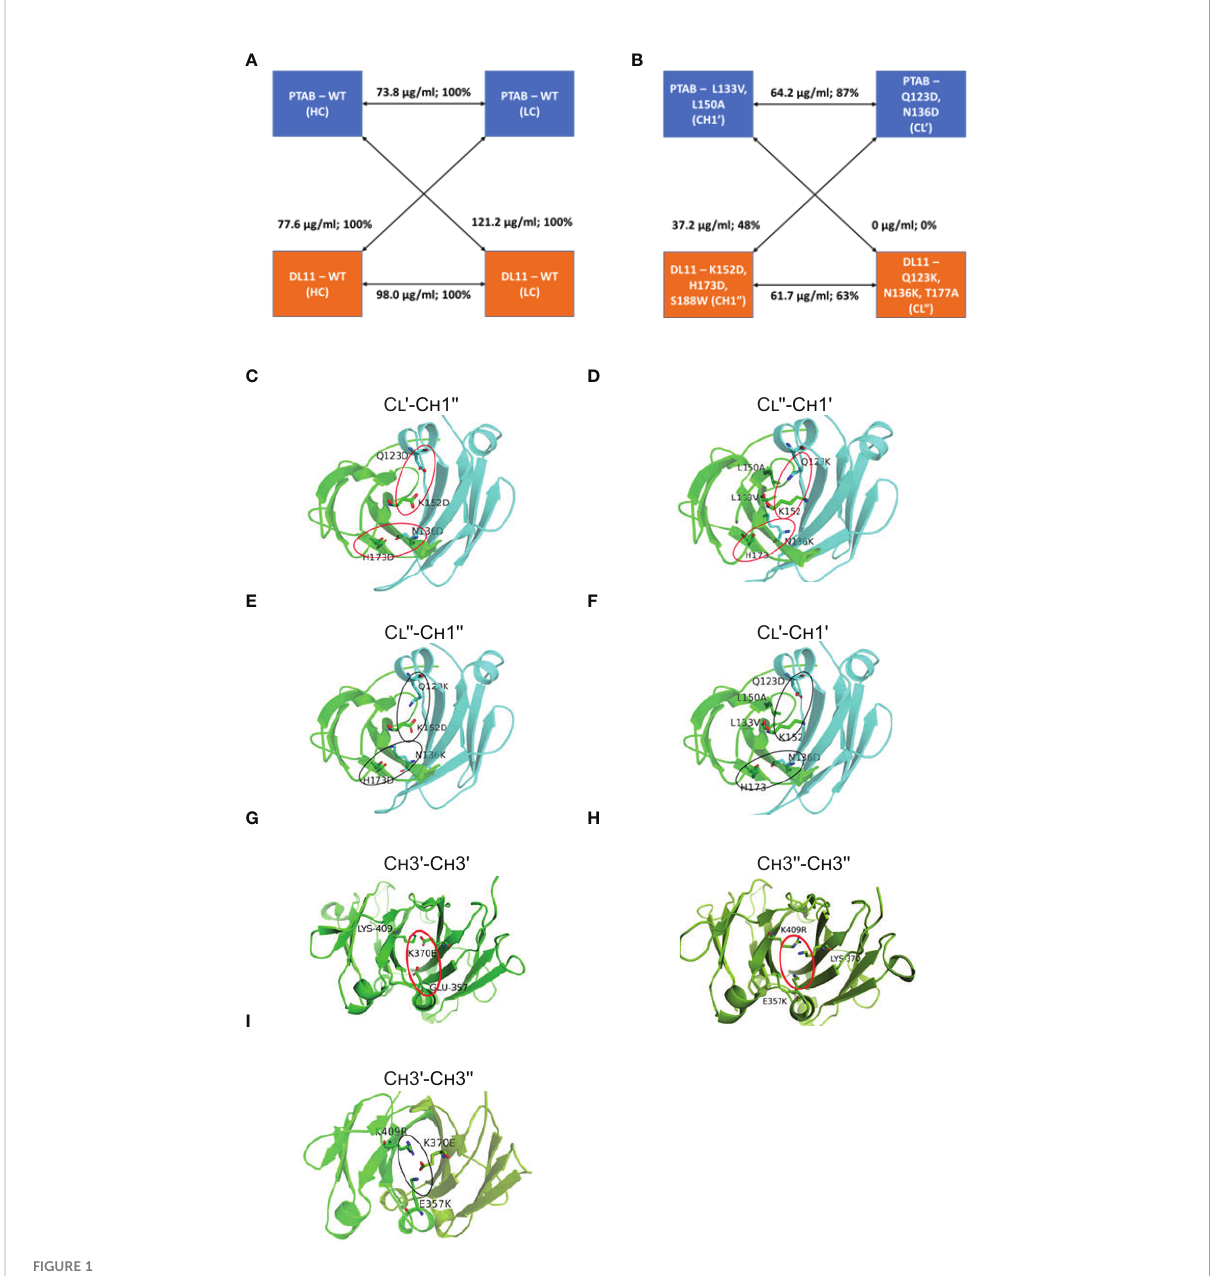
FIGURE 1 Structure-guided redesign of C H 1-C L interface for BsAb engineering. Expression levels of cognate paired and mispaired monospeci fi c species formed by heavy and light chains of pertuzumab (PTAB) and DL11 (A) without mutations and (B) with mutations. Rendered in (C-F) are the 3D derived models of the C H 1 and C L domain interface observed in PDB: 3BKY, where the view is perpendicular to the pseudo-2-fold axis. The C H 1 and C L domains are colored in green and cyan, respectively. The side chains of the modi fi ed C H 1-C L interface residues and WT residues that aid or perturb the C H 1-C L interface are represented as sticks and labeled. Attractive and repulsive interactions are circled using black and red ovals, respectively. (G – I) Network and two-fold axis relationship of mutants to enhance heterodimerization of C H 3 domains in BsAbs. The view is looking down on the 2-fold axis of symmetry. The C H 3 domains of the two antibodies are colored in green and splitpea, respectively. Potential repulsive interactions that emerge in C H 3 homodimers, such as Glu357- Lys370Glu (G) and Glu357Lys - Lys370, Lys409Arg - Lys370 ( H ), are highlighted by red oval, whereas the interactions that enhance the heterodimer formation in the BsAb are highlighted by black oval ( I ). Note that the instance of the interactions that is away from the reader is not shown, for